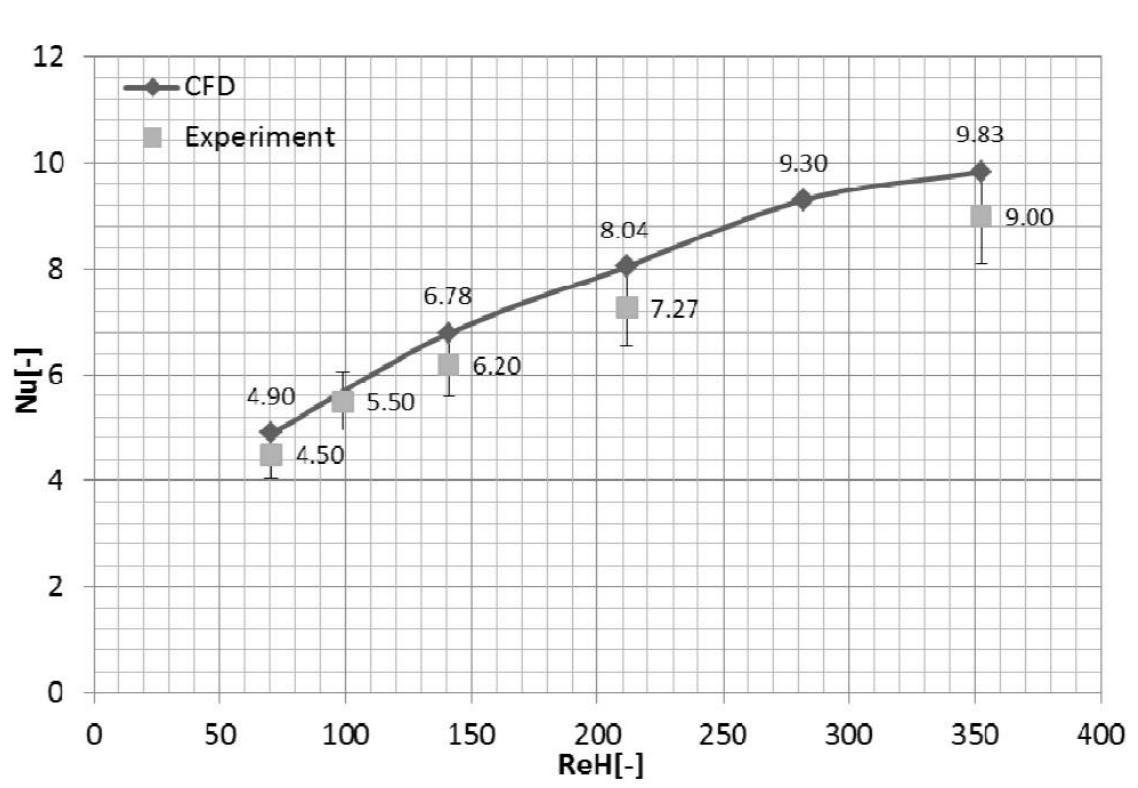
Figure 7: Comparison of numerically & experimentally achieved average Nusselt number for the louvered fin